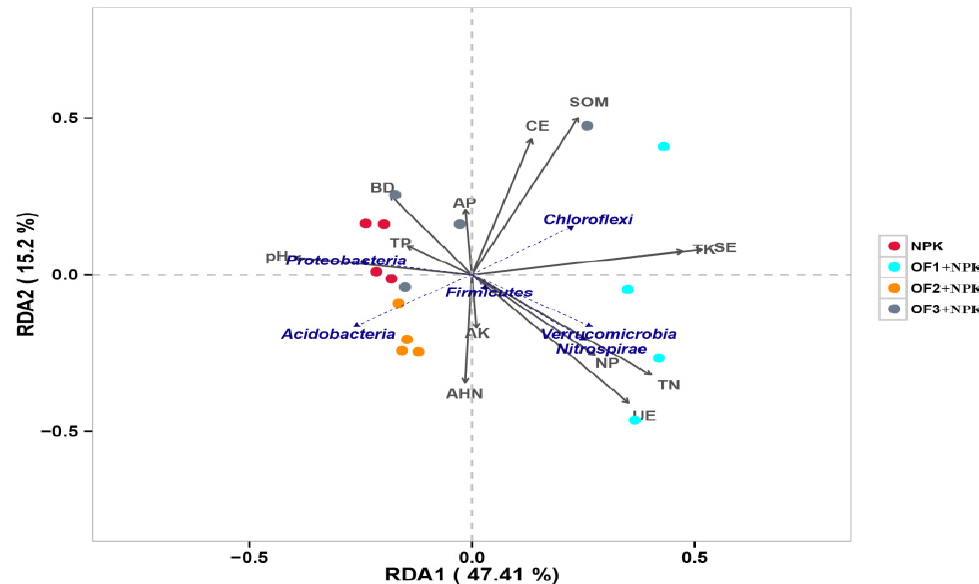
Figure 5. Redundancy analysis of the relationship between bacterial community distribution and soil properties under different fertilization treatments. NPK, conventional fertilization; OF1 + NPK, seaweed bio-organic fertilizer and NPK; OF2 + NPK, Jishiwang bio-organic fertilizer and NPK; OF3 + NPK, attapulgite organic fertilizer and NPK. AHN, alkaline hydrolyzable nitrogen; AK, available potassium; AP, available phosphorus; BD, bulk density; CE, catalase; NP, neutral phosphatase; SE, invertase; SOM, soil organic matter; TK, total potassium; TN, total nitrogen; TP, total phosphorus; UE, urease.